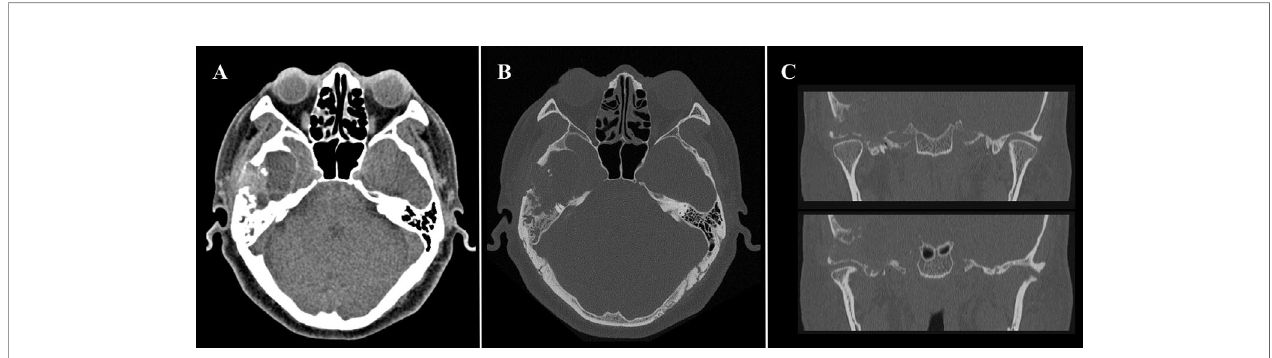
FIGURE 1 | Computed tomography (CT) of a 48-year-old man with diffuse tenosynovial giant cell tumor (D-TSGCT) in right temporomandibular joint (TMJ). (A) A heterogeneous-density mass in the right temporomandibular joint region (soft tissue window, axial view). (B) Involvement of the temporal squamous and petrosal bones (bone window, axial view). (C) Erosion of the temporal bone while the condylar head was preserved (bone window, coronal